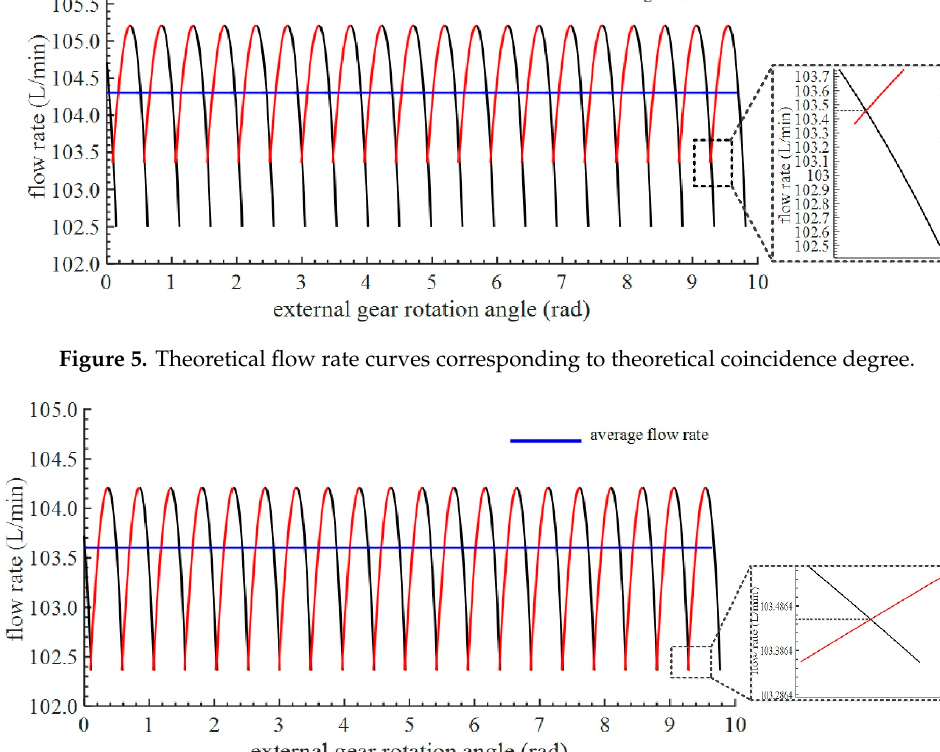
Figure 5. Theoretical flow rate curves corresponding to theoretical coincidence degree.